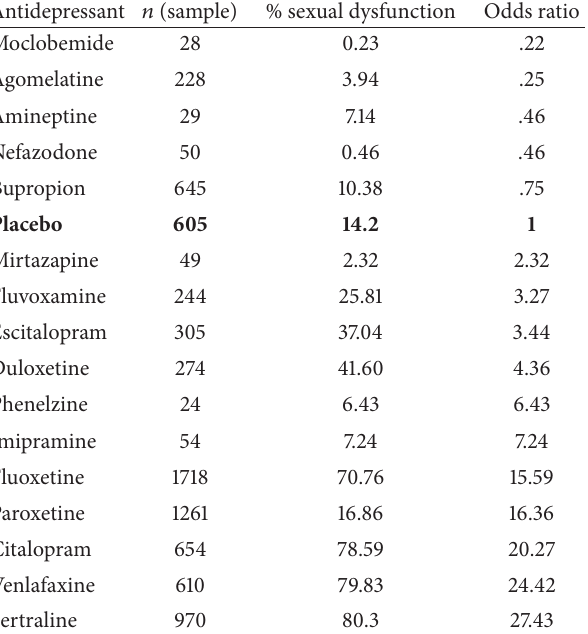
Table 1: Estimated proportion and relative likelihood of treatment- emergent sexual dysfunction (derived from Serretti and Chiesa